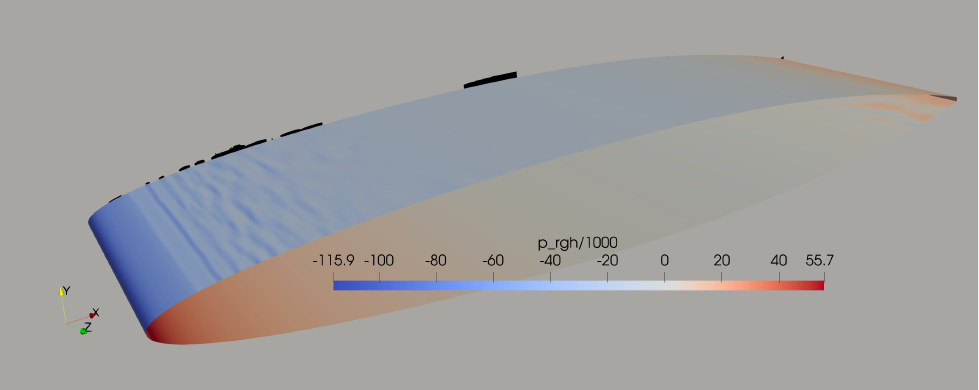
Figure 10. Predicted non-cavitating SepInd (marked in black) and pressure on foil surface at Reynolds number of 1,000,000, 3D